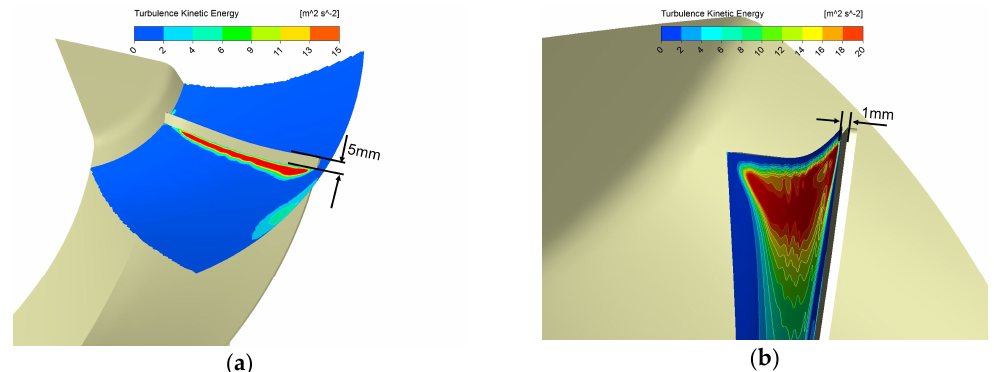
Figure 4. Locations for turbulence kinetic energy (TKE) quantifying and presenting: ( a ) Spanwise face, 5 mm from the leading edge chordwise (SF_5mm), ( b ) Offset face, 1 mm from the suction surface in its normal direction (Off_Suc_1mm).